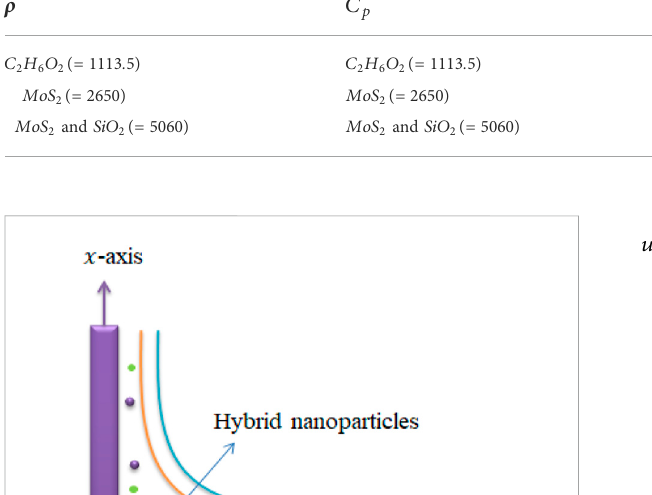
TABLE 1 Thermo-physical properties [41] for σ , k , C p , and ρ . ρ C p